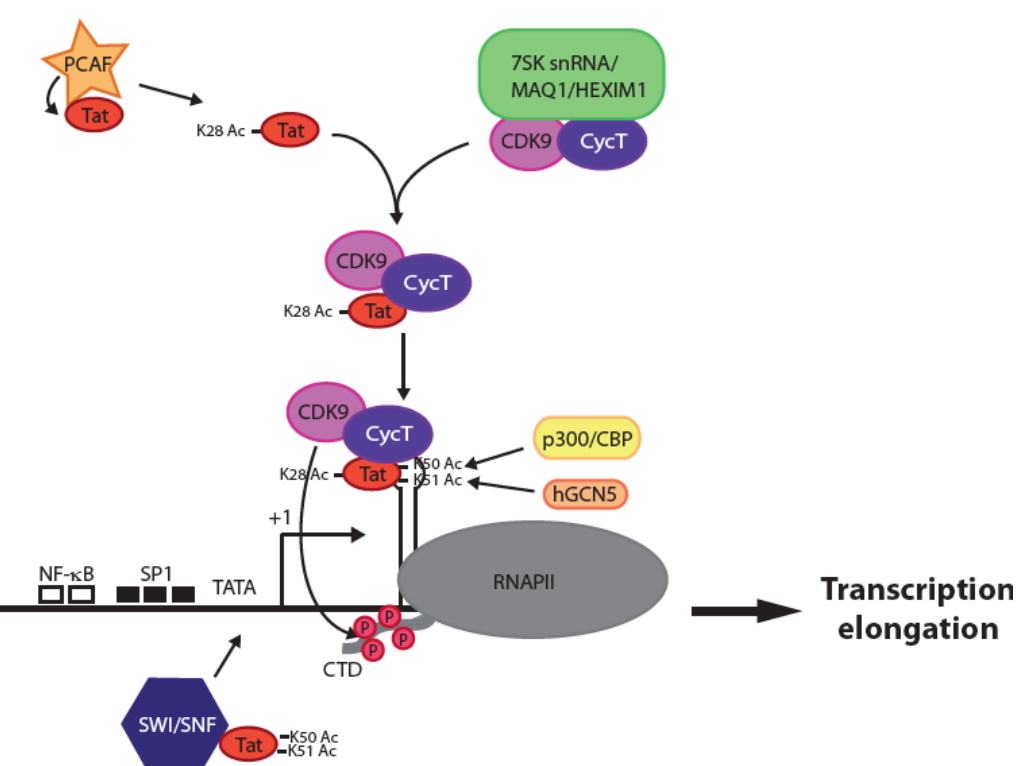
Figure 1. Upon Tat acetylation on Lys28 by PCAF, Tat recruits P-TEFb (CDK9/Cyclin T1) from its inactive complex with 7SK snRNA/MAQ1/HEXIM1. Tat/P-TEFb complex binds to TAR. CDK9 phosphorylates Ser2 of the RNAPII CTD stalled shortly after transcription initiation and promotes transcription elongation. Tat is acetylated at Lys50 and Lys51 by p300/CBP and hGCN5, resulting in the release of the complex from TAR. Tat then recruits to the initiation start site SWI/SNF, PCAF and RNAPII and other factors not depicted here to promote further